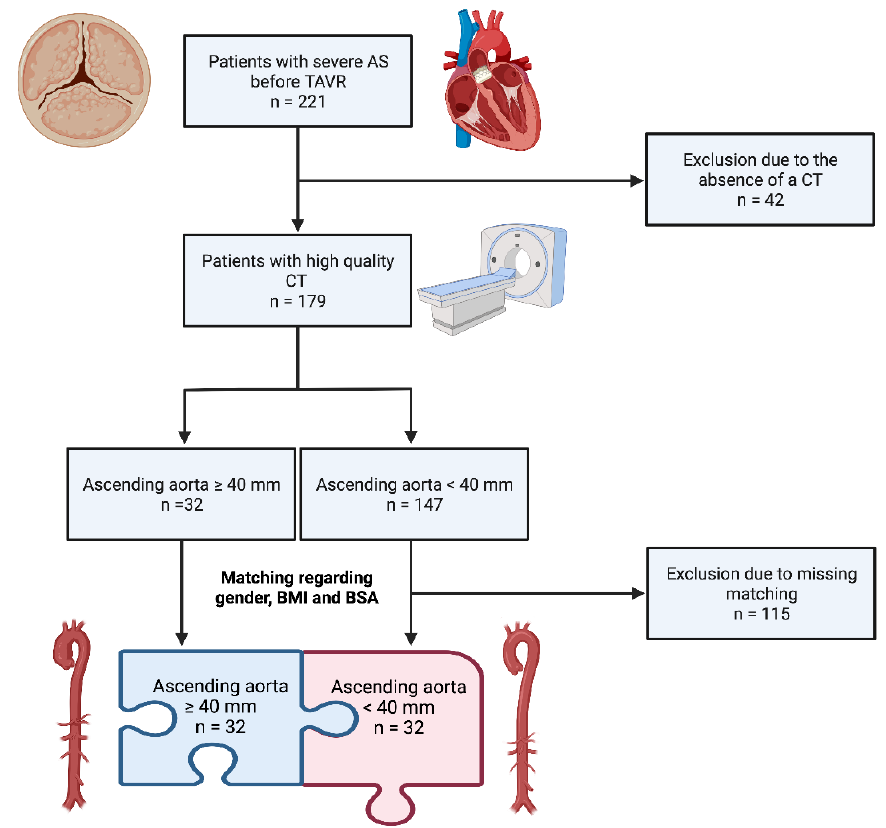
Figure 1. Flow chart with inclusion criteria of the study (created with BioRender.com). AS: aortic stenosis; CT: computed tomography; TAVR: transcatheter aortic valve